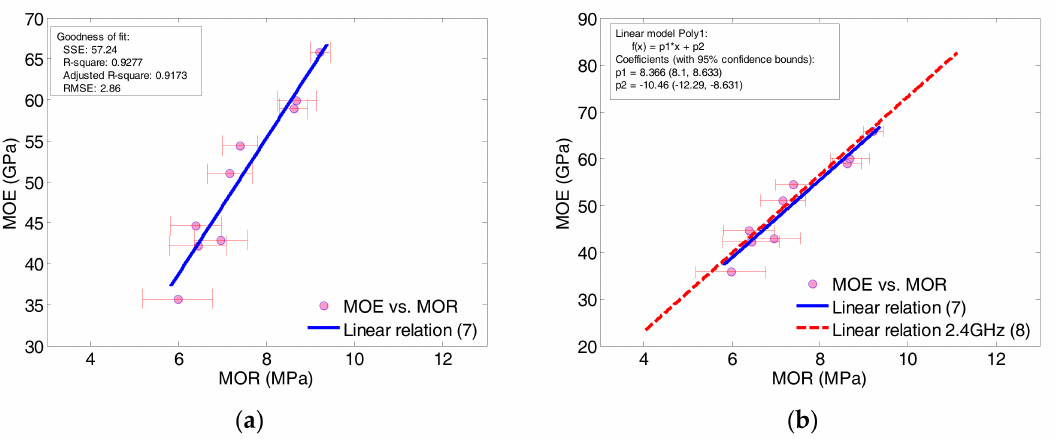
Figure 12. Relations between MOE in GPa and MOR in MPa of ECC specimens: ( a ) obtained by fitting measured data; ( b ) verified by mapping Equations (5) and